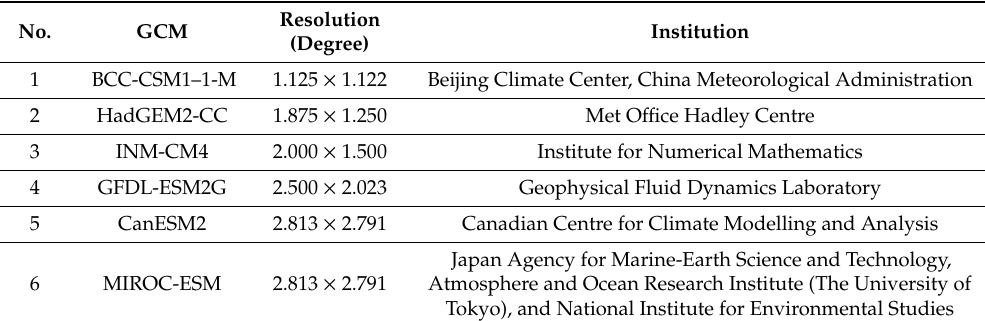
Table 1. Information about the global climate models (GCMs) used in this study.